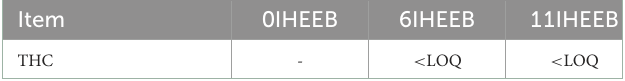
TABLE 2 Ingredients and chemical composition (% of DM) of the 3 diets a